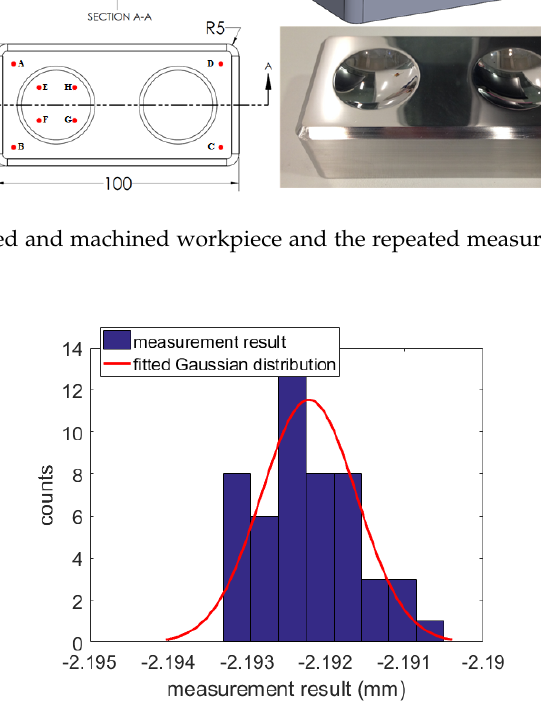
Figure 18. Mean surface and associated uncertainty after Gaussian process modelling: ( a ) mean surface; and ( b ) associated uncertainty.